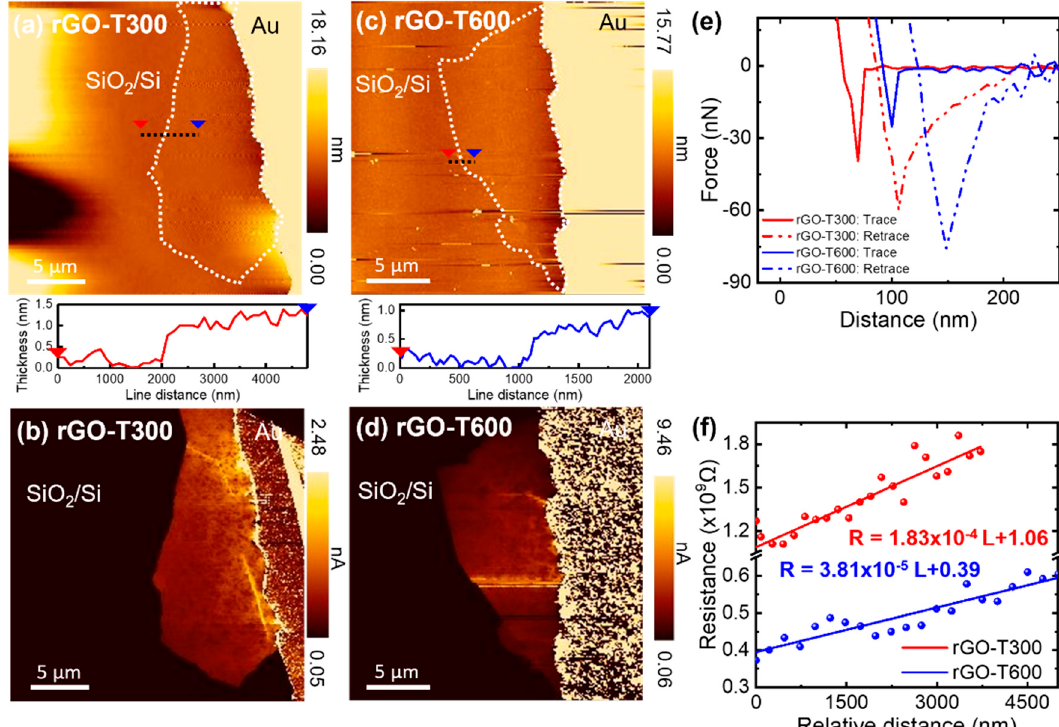
Figure 7. ( a , b ) AFM images for the ( a ) topography and ( b ) current distribution of the rGO flake annealed at 300 °C. ( c , d ) AFM images for the ( c ) topography and ( d ) current distribution of the rGO flake annealed at 600 °C. ( e ) Force–distance curves. ( f ) Resistance profiles of the rGO flakes as a function of the distance from the tip to the electrode.